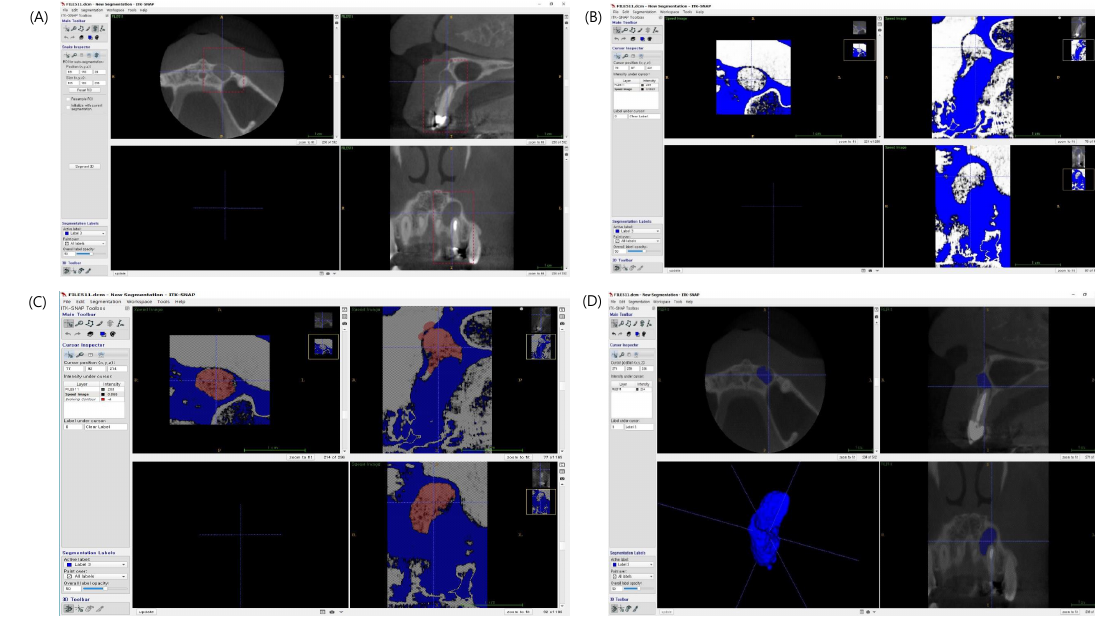
Figure1.LesionvolumecalculationusingITK-SNAP.(A)manualsegmentationofaperiapicaldefectinsagittal,axialandcoronalviews.(B)selectionofperiapicaldefectsusingagrayscalevaluerangeselection tool.(C)semiautomaticdefectvolumerecognition(D)reconstructionof3Dimageonalesionandcalculationofthelesionvolume. Figure 1. Lesion volume calculation using ITK-SNAP. ( A ) manual segmentation of a periapical defect in sagittal, axial and coronal views. ( B ) Selection of periapical defects using a grayscale value range selection tool. ( C ) Semiautomatic defect volume recognition and ( D ) reconstruction of 3D image on a lesion and calculation of the lesion